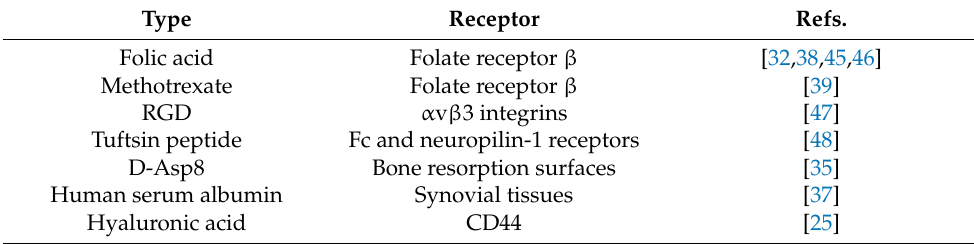
Figure 4. Schematic preparation and cellular uptake of HANPs/MD with high affinity to macrophages. Reprinted with permission from Ref. [44]. Copyright © 2020 Elsevier B.V. All rights reserved. Table 2. Active targeting ligands for RA gene treatment.